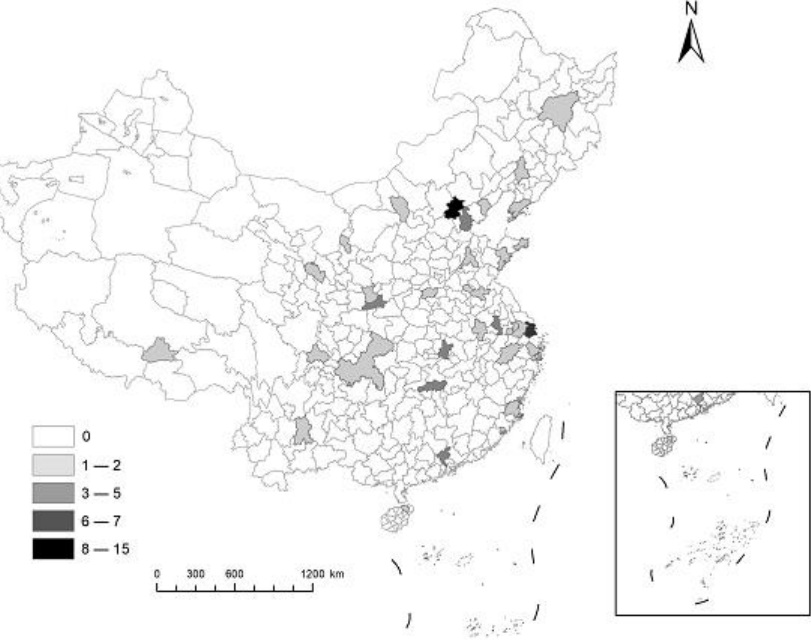
Figure 1. Regional distribution and quantity of sample universities in China. Note: This figure presents the regional distribution and quantity of all sample universities in China, and the different degrees of gray represent the different amounts of universities in each city.